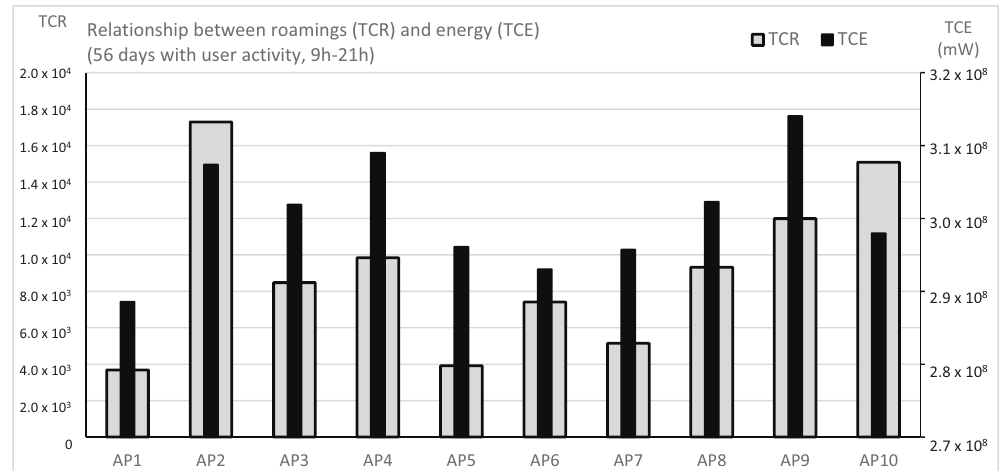
Figure 5. Proportional point relationship between energy ( TCE ) and roamings ( TCR ) in the APs during the period for the full network, given by the coefficients C